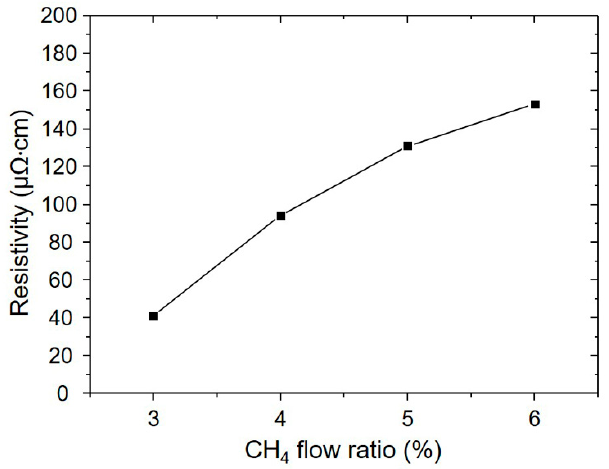
Figure 9. Electrical resistivity versus CH 4 flow ratio.